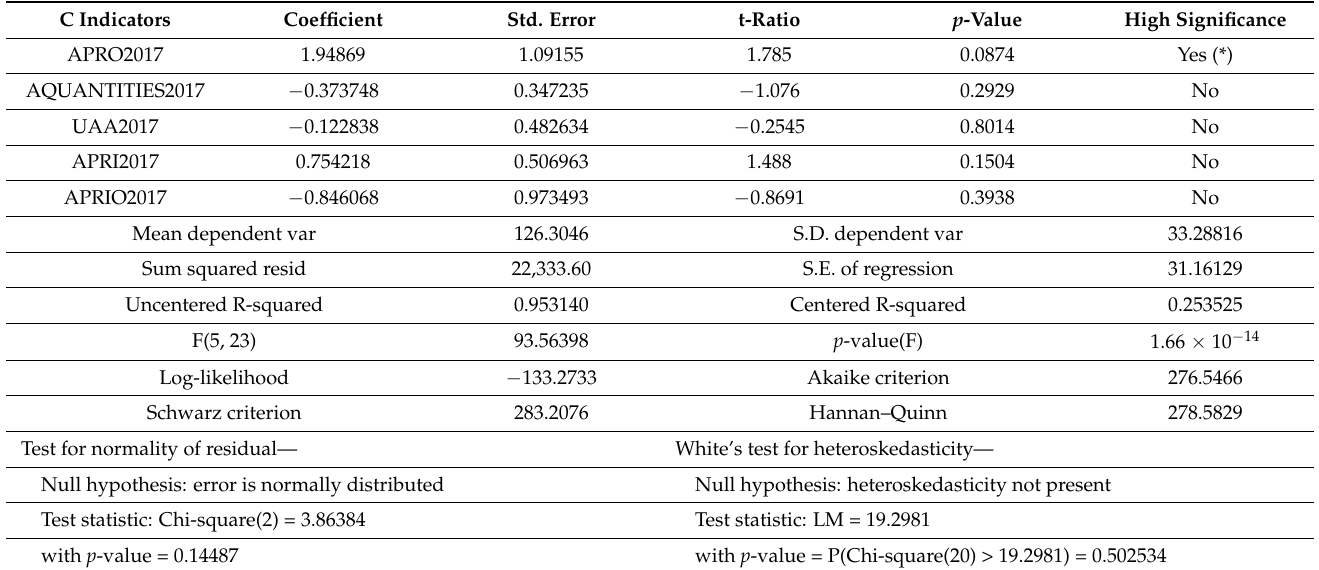
Table 7. Model 2017: OLS, using observations 1–28 (Dependent variable: